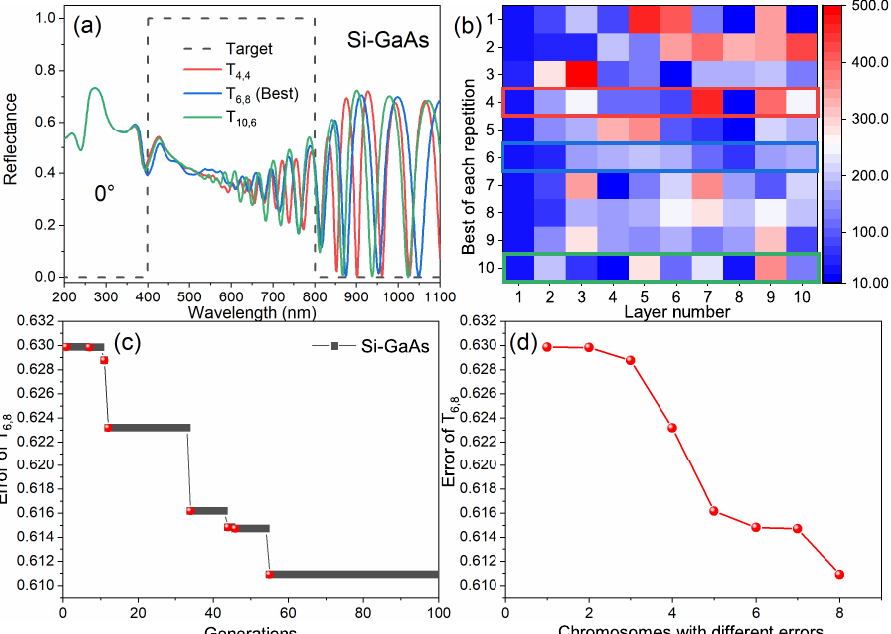
Figure 4. The optimization results for a Si-GaAs PC: ( a ) The black dashed lines represent the target reflectance, while the solid colored curves show the characteristic optimized spectra corresponding to the best individuals of each run for 0 ◦ of incidence; ( b ) Solution to the individual chromosome representation; ( c ) Genetic algorithm convergence process; ( d ) Chromosomal representation of the solutions with a different error. These chromosomes are the ones that present genetic variability and are the ones selected to save in the database (h5